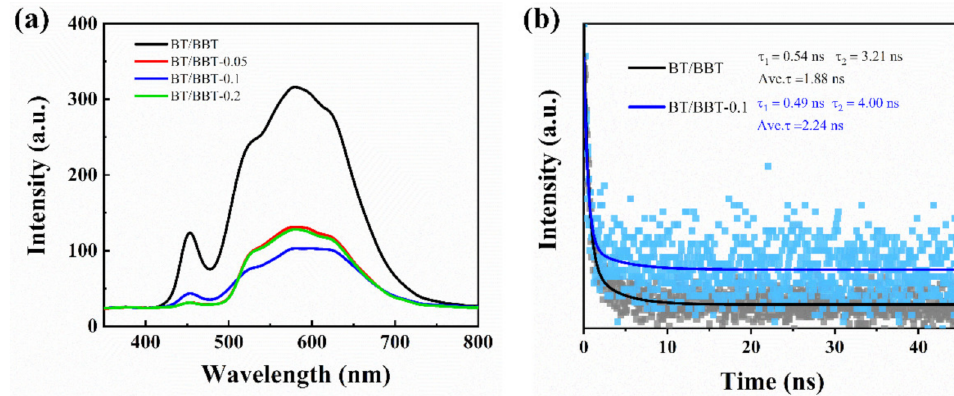
Figure 6. ( a ) PL spectra, ( b ) fluorescence lifetime of BT/BBT and BT/BBT-0.1 samples.